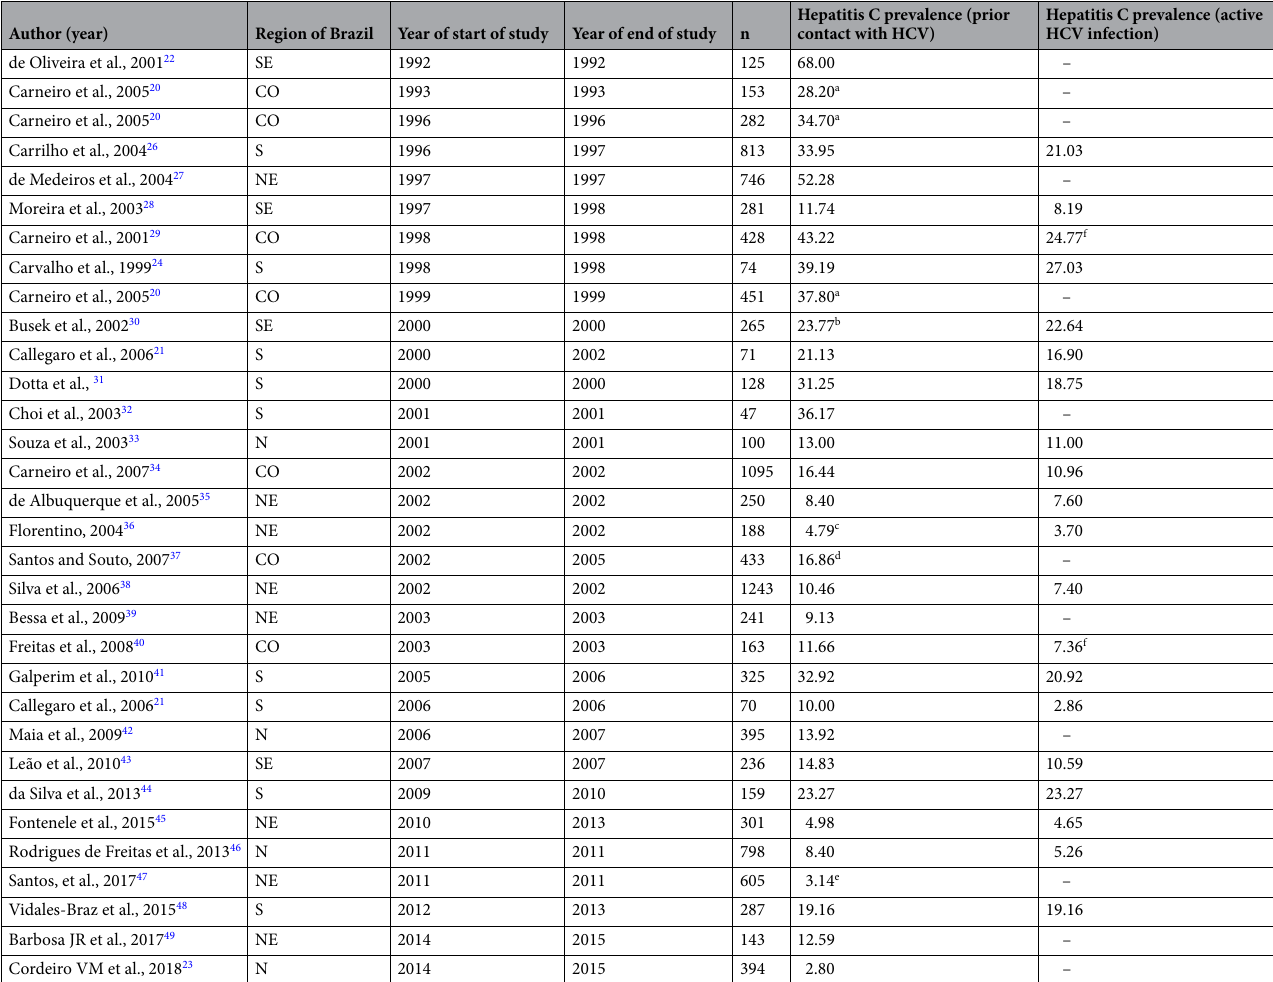
Table 1. Prevalence rates of HCV infection in haemodialysis patients in Brazil according to major geographic region in which the study was conducted, year of start of study, and study population/sample size. Studios that used different diagnostic method: a ELISA + and LIA + ; b EIA III + ; c ELISA III + or Detect ® for HCV, version 3.0, ALKA laboratory; d MEIA III + ; e CLIA + and ECLIA + ; f LIA + and PCR